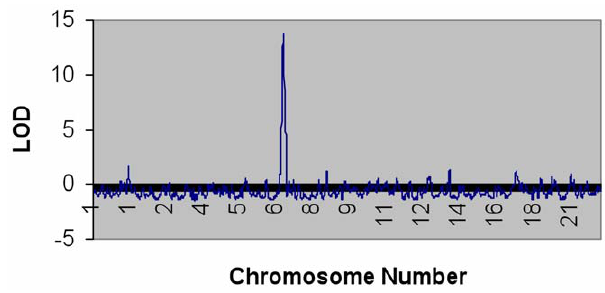
Figure 1. Affected-Only Statistic at Equally Spaced Points across the genome for the Lp(a) Admixture Scan. The 95% credible interval for the peak at 6q25.3 includes the LPA and LPA2 genes.